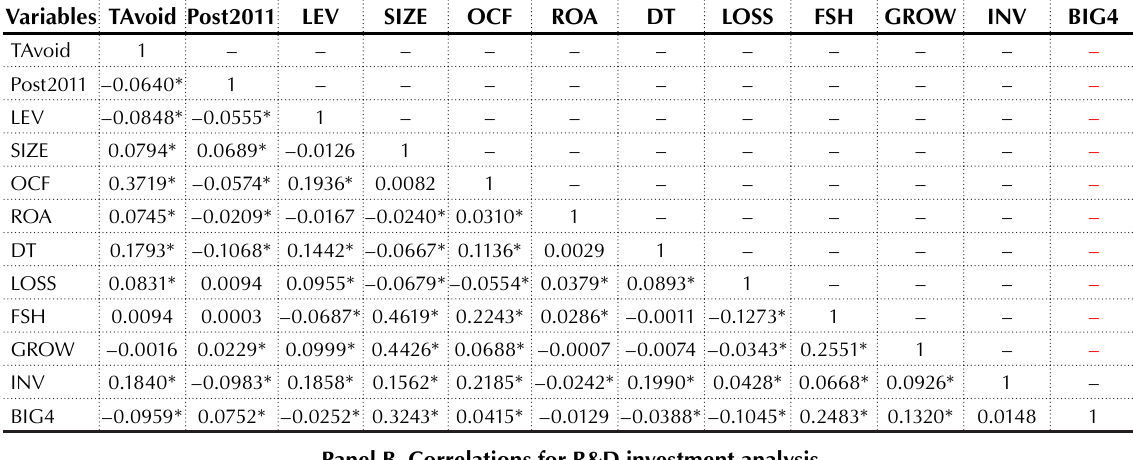
Table 3. Correlations Panel A. Correlations for tax avoidance